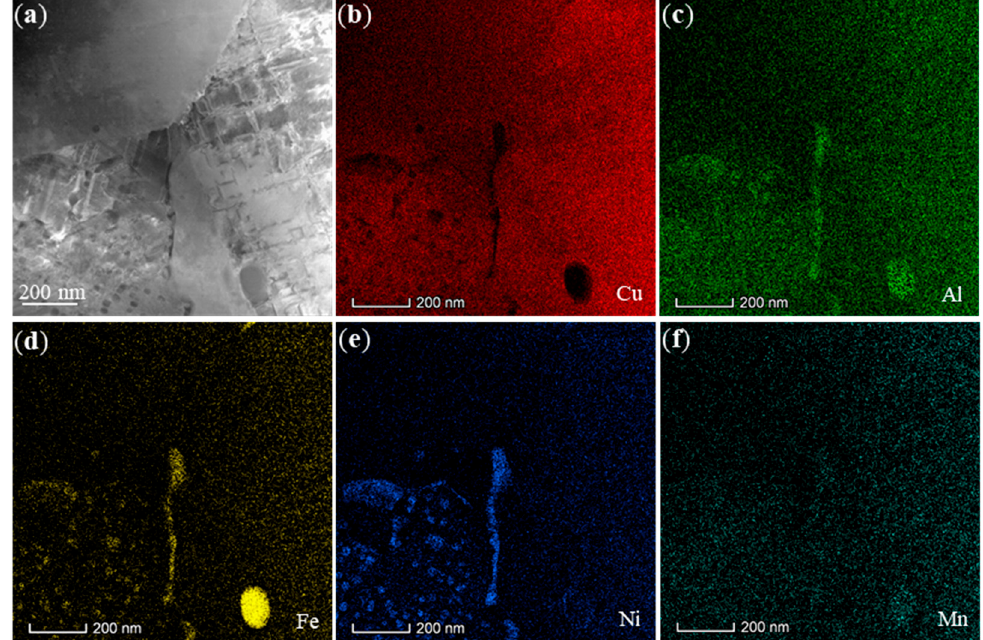
Figure 8. ( a ) HAADF image of the UVA treatment WAAM in the interdendritic region, ( b – f ) corresponding EDS elemental maps for Cu, Al, Fe, Ni, and Mn, respectively. The globular precipitates are Fe 3 Al ( κ II ) and the lamellar precipitates are NiAl ( κ III ) in the interdendritic region.